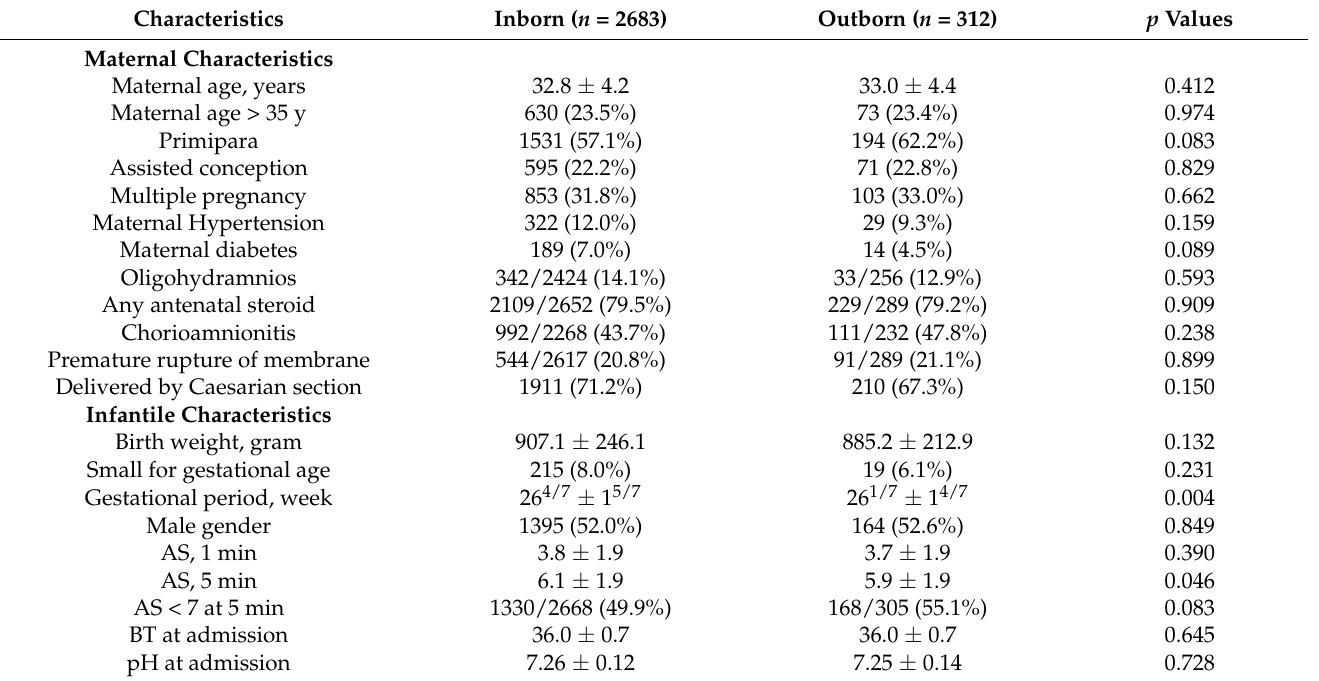
Table 1. Antenatal and perinatal